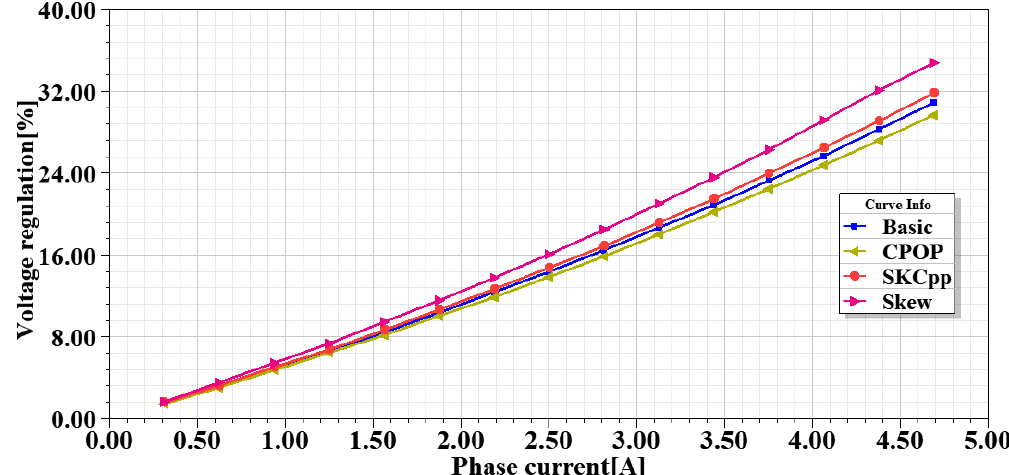
Figure 30. Voltage-regulation against phase current (rms) for each rotor designs @ 375 r/min.